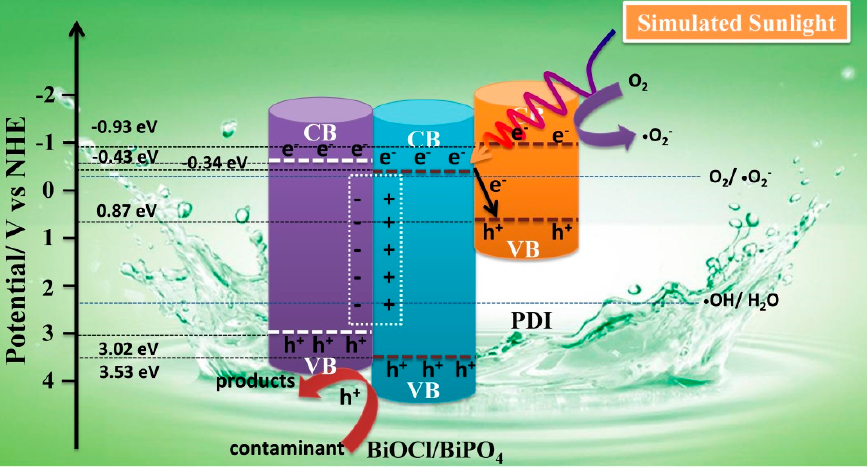
Figure 10. Proposed mechanism of the enhanced photocatalytic activity for PDI/BiOCl-BiPO 4 composite photocatalysts.